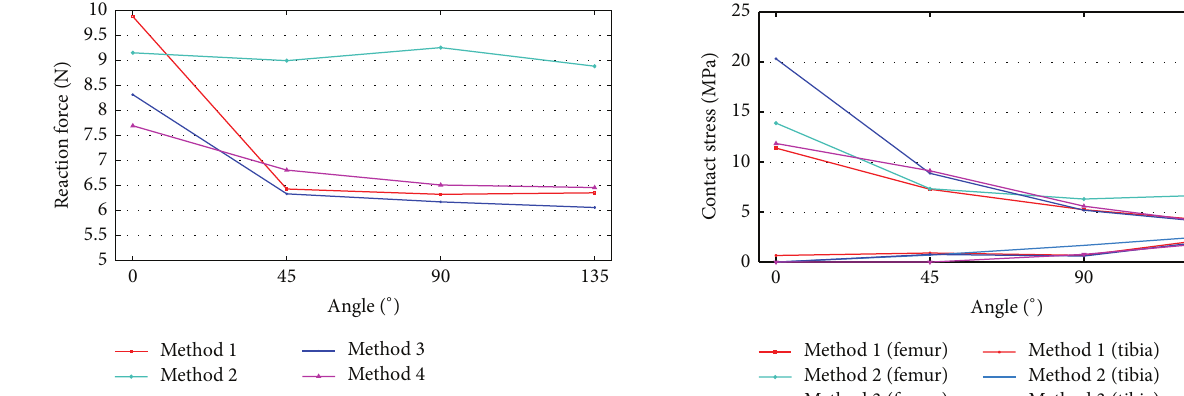
Figure 13: Reaction force changes in the tied sections of the models.